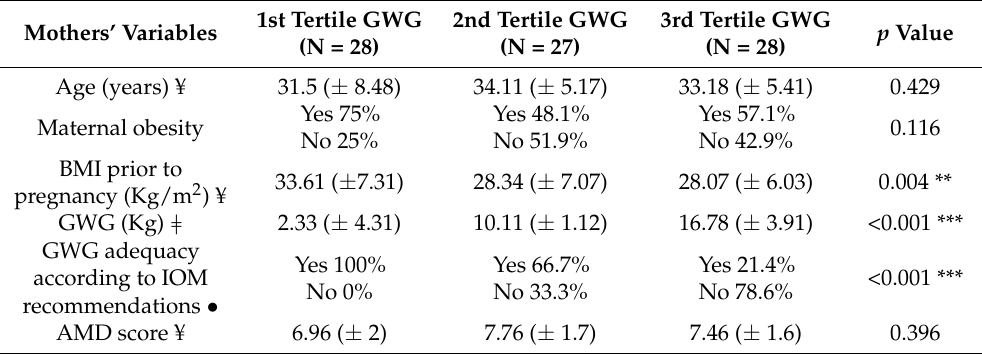
Table 1. Characteristics of mothers, according to absolute maternal GWG tertiles. Data are presented as either mean ± SD or no. (%). } Analysis of variance (ANOVA). ¥ The Kruskal Wallis test. • Chi- squared test. Data with significant p -values are labeled as follows: ** for p < 0.01 and *** for p < 0.001. Mothers’